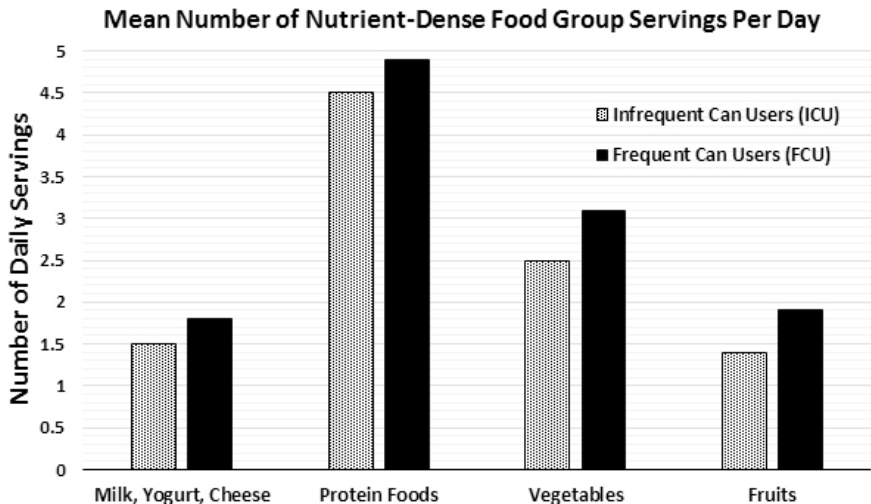
Figure 1. Mean number of nutrient-dense food group servings per day among frequent and infrequent canned food users (FCU and ICU). Proportion of infrequent ( n = 2732) and frequent ( n = 2584) canned food users average daily intake of nutrient-dense food groups. Data from The National Purchase Diary (NPD) Group’s National Eating Trends ® intake diary panel 2011–2013 and Nutrient Intake databases. Statistical confidence level set at 95% for two-tailed t test. p -Value < 0.025% considered significant. The FCU group had significantly higher values for all food groups listed ( p < 0.01).